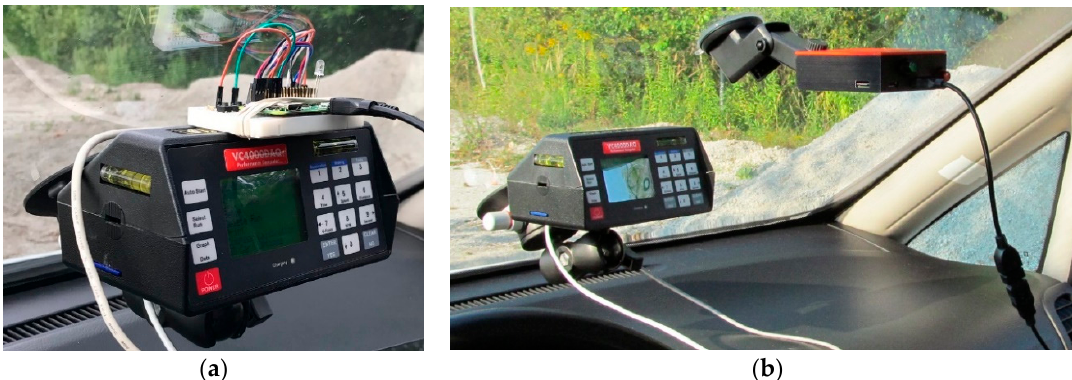
Figure 5. ( a ) Breadboard prototype on the calibrated measurement device during initial testing; ( b ) Finished prototype and the calibrated measurement device mounted on the vehicle windshield, ready for brake testing.